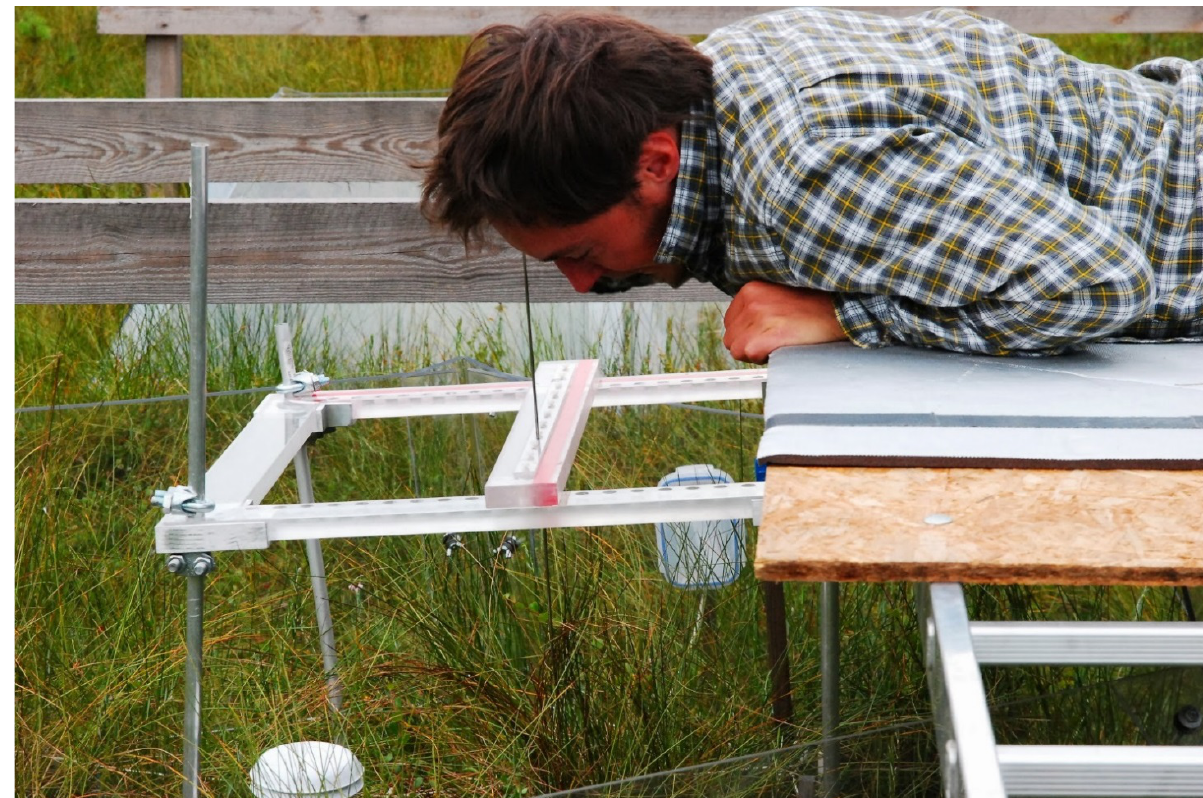
Figure 6. Point-intercept vegetation study - fieldwork (photo Thomasz Horla, summer